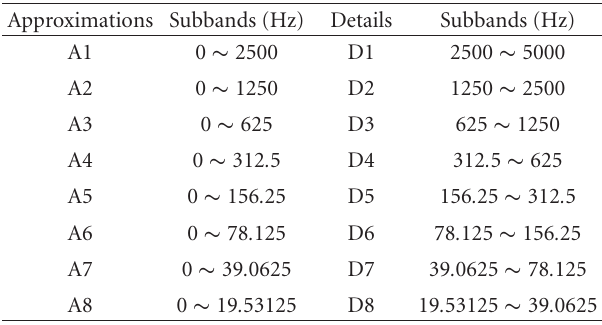
Table 3: Frequency levels of the motor stator current signal.